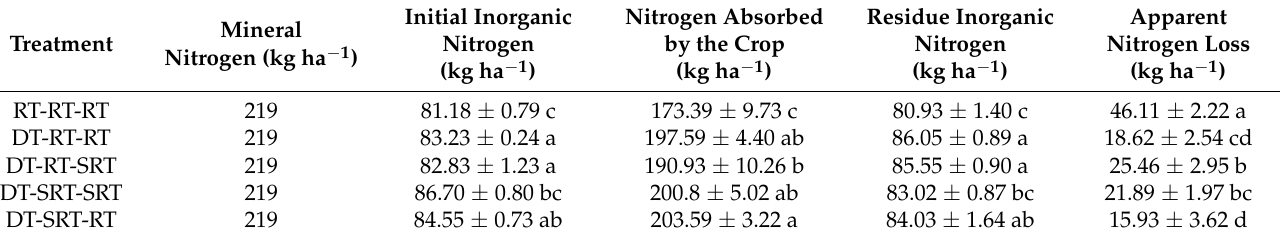
Table 3. The nitrogen balance under different treatments in 2019.